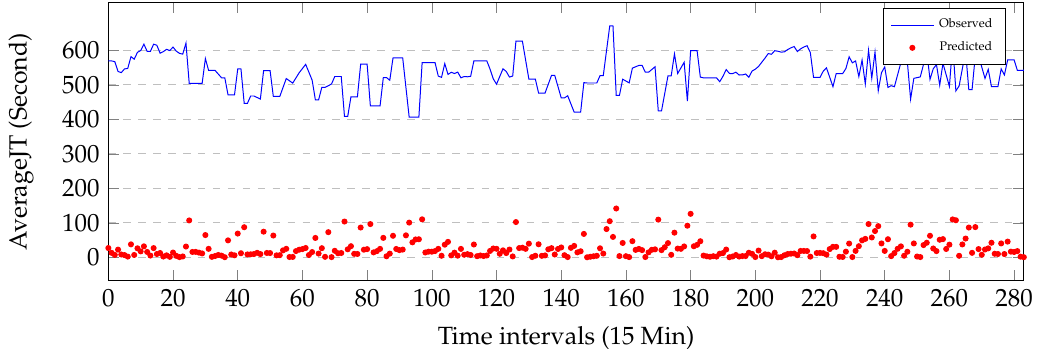
Figure 7. Absolute values of the residuals against the observed data during 3 days on link AL281. The horizontal axis is time intervals and the vertical axis is